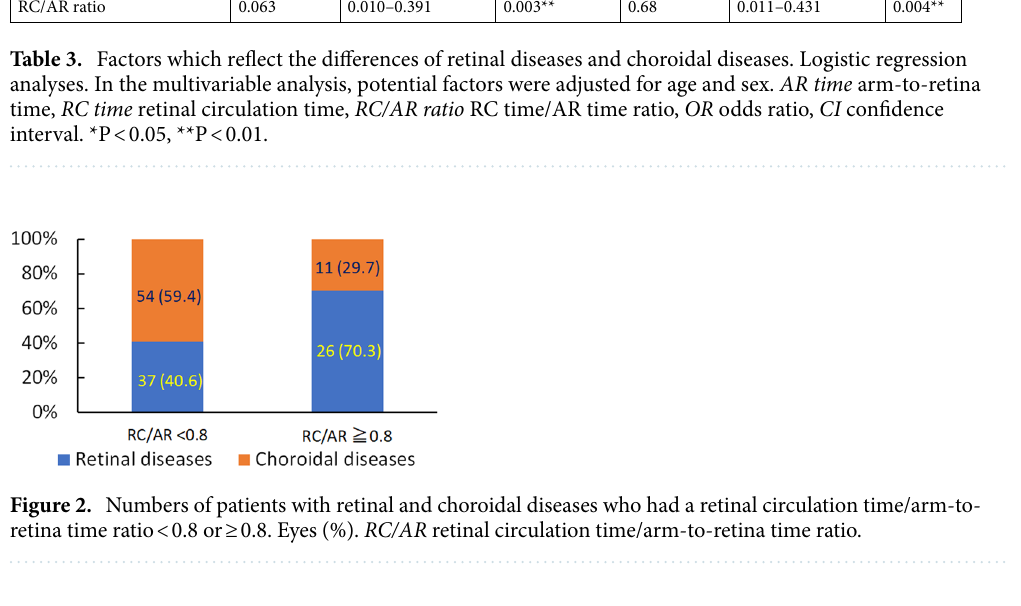
(Table 3). After adjusting for age and sex, RC time (odds ratio, 0.820; 95% confidence interval, 0.716–0.939; P = 0.004) and the RC/AR ratio (odds ratio, 0.680; 95% confidence interval, 0.011–0.431; P = 0.004) remained significantly different between the groups (Table 3).